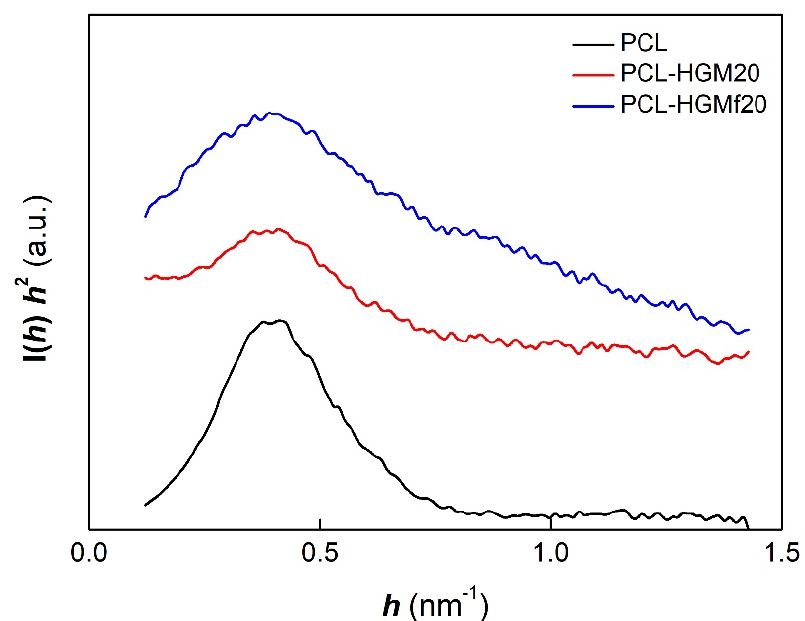
Figure 10. SAXS profiles for samples isothermally crystallized at 46 °C.